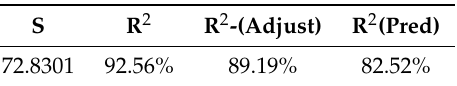
Table 3. Summary of the